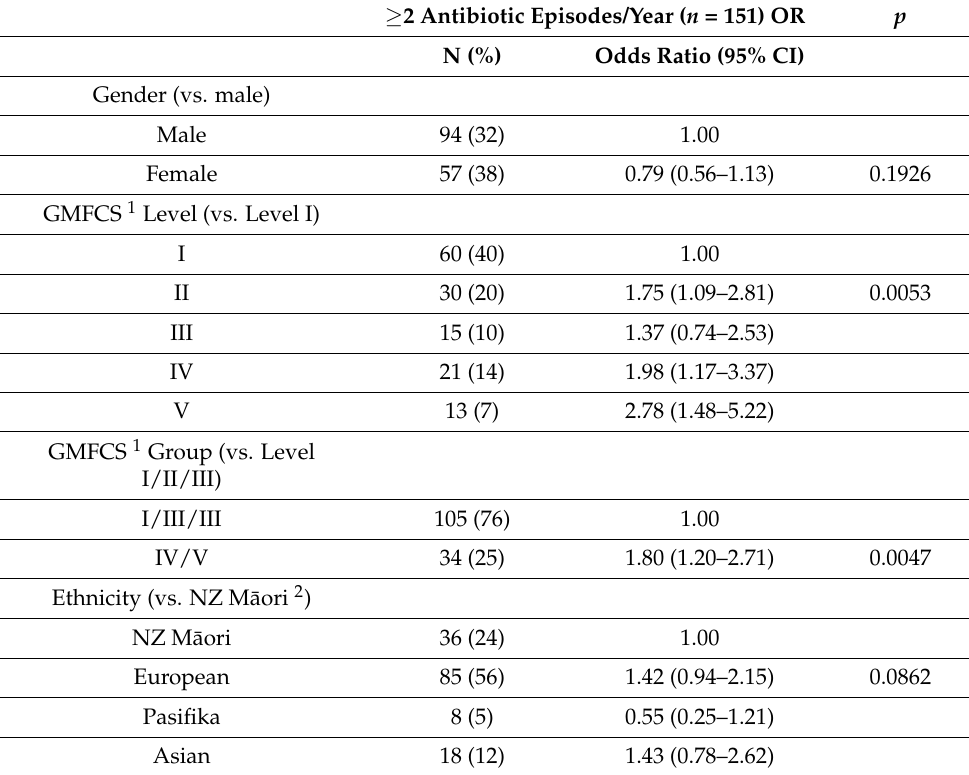
Table 4. Univariate analysis and odds ratio analysis for ≥ 2 antibiotic episodes per year for gender, GMFCS, ethnicity, and NZDep quintile.